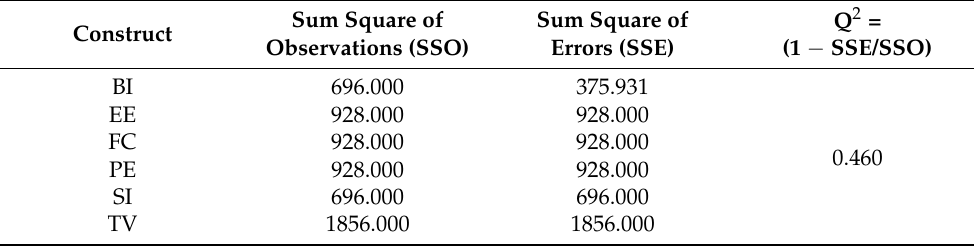
Table 7. Construct cross-validated redundancy.